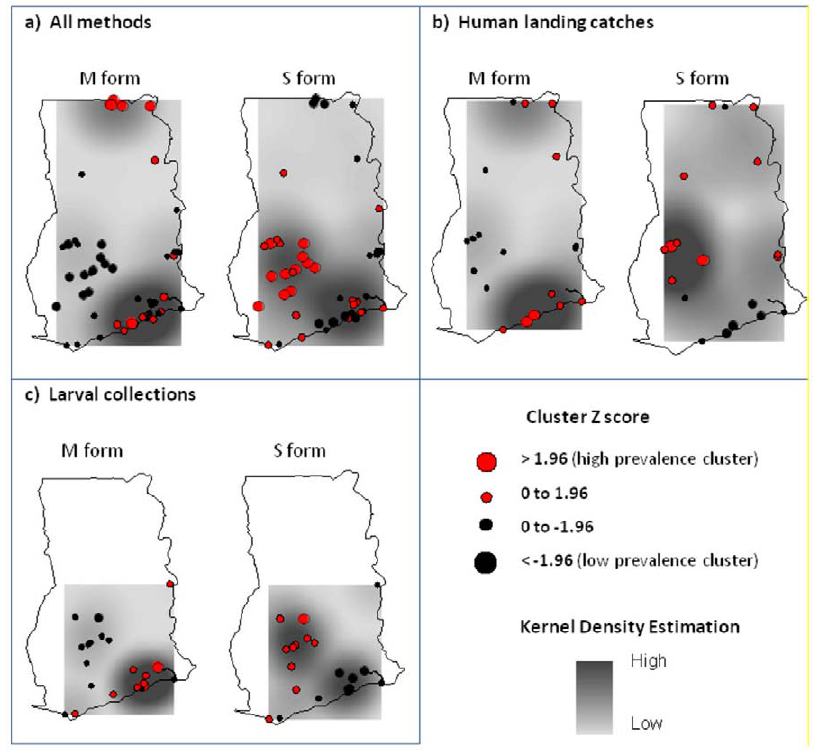
Figure 3. Spatial clustering trends and density distributions of An.gambiae s.s molecular forms.